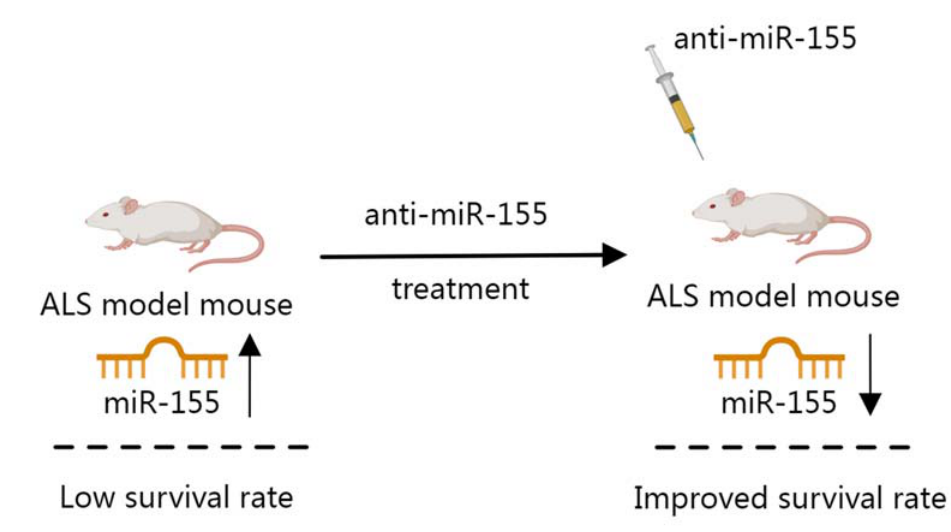
Figure 6. Role of miR ‐ 155 in a mouse model of ALS.